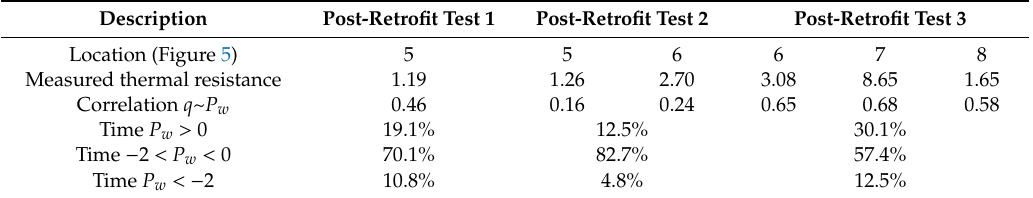
Table 9. Correlation between the measured heat fluxes (q) and wind pressure (P w ) on the post-retrofit front